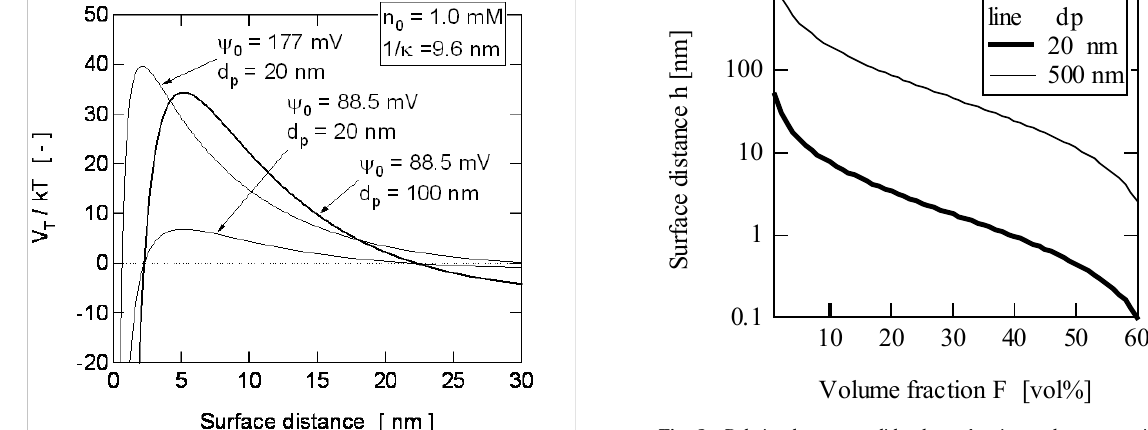
Fig. 2 Relation between solid volume fraction and mean particle sur- face distance. Fig. 1 Example of the potential curves calculated by DLVO